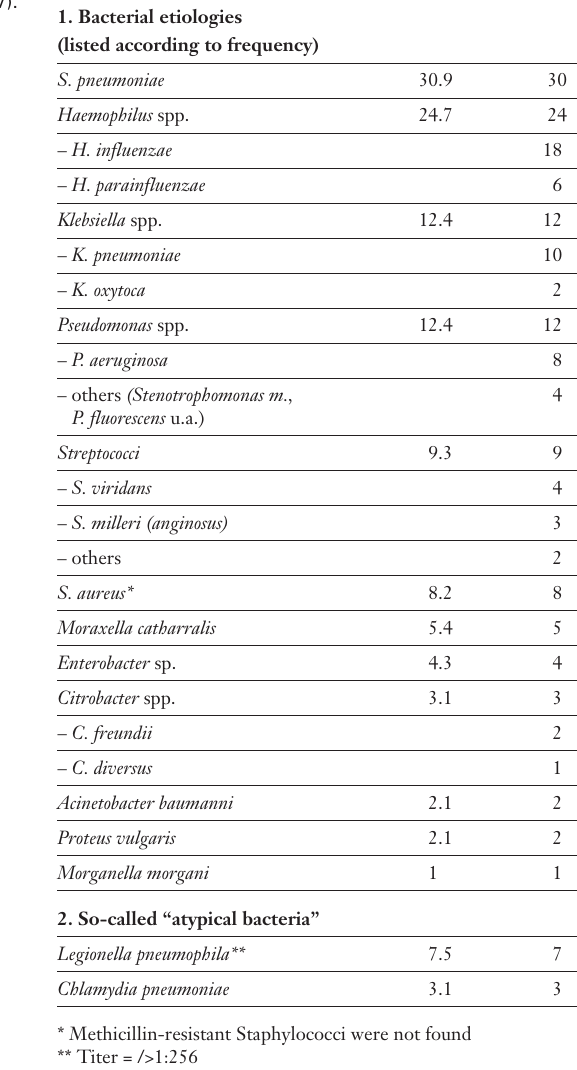
Bacteriology (n = 97).